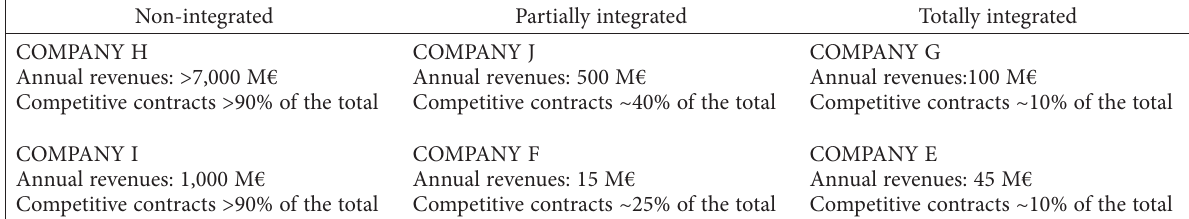
Table 3. Characteristics of companies E, F, G, H, I and J in relation to the selection criteria Non-integrated Partially